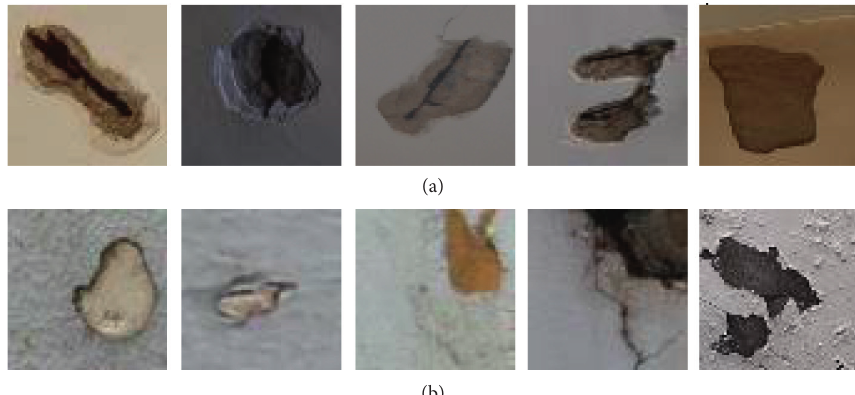
Figure 3: Demonstration of the collected image samples: (a) images containing localized spall objects and (b) images containing non- localized spall